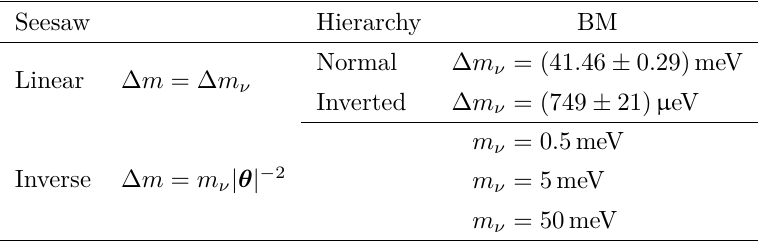
Table 1 . Five BMs for the linear and inverse seesaw are discussed in the text. The linear seesaw BMs represent the only two possible models in the minimal linear seesaw of a single pseudo-Dirac heavy neutrino. With more pseudo-Dirac heavy neutrinos in the spectrum, other models become feasible. Since the inverse seesaw requires at least two pairs of pseudo-Dirac neutrinos, it is not possible to uniquely connect it to the measured neutrino mass differences, and we use a wide spectrum of neutrino masses as